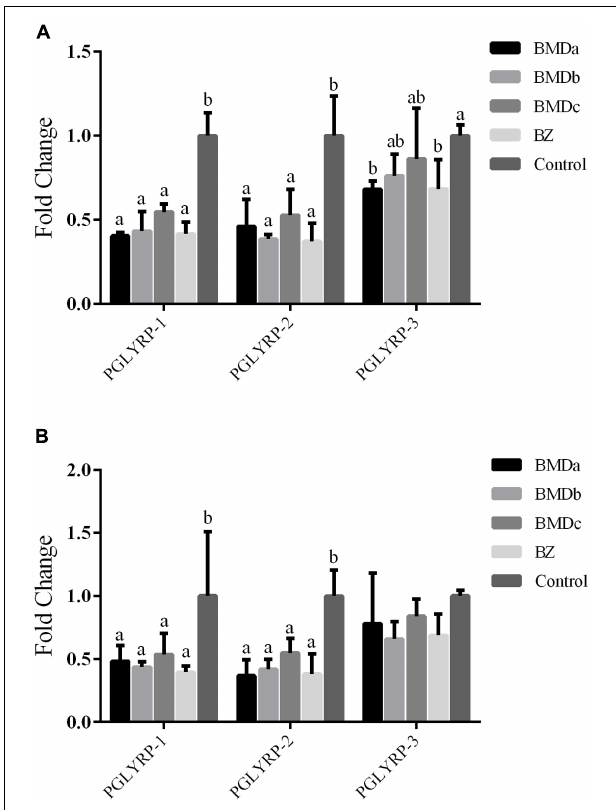
FIGURE 2 | Expression of PGRPs in the cecum and duodenum. (A) Expression of PGRPs in the cecum. (B) Expression of PGRPs in the duodenum. a,b indicate significant differences within a row ( P < 0.05).